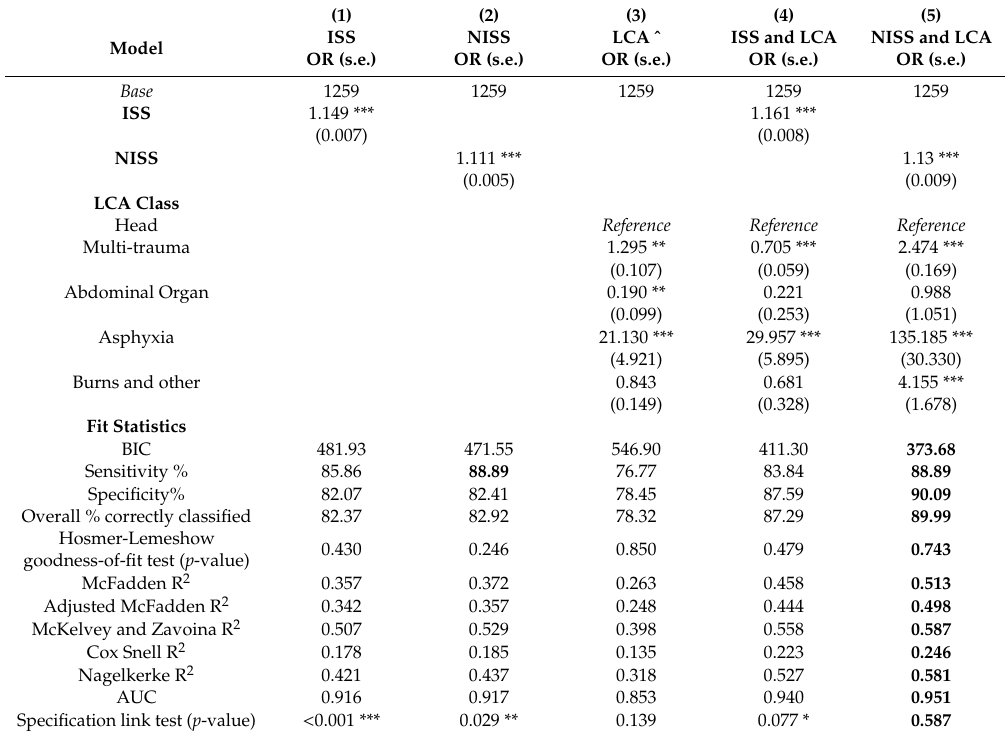
Table 4. Mortality logistic regression